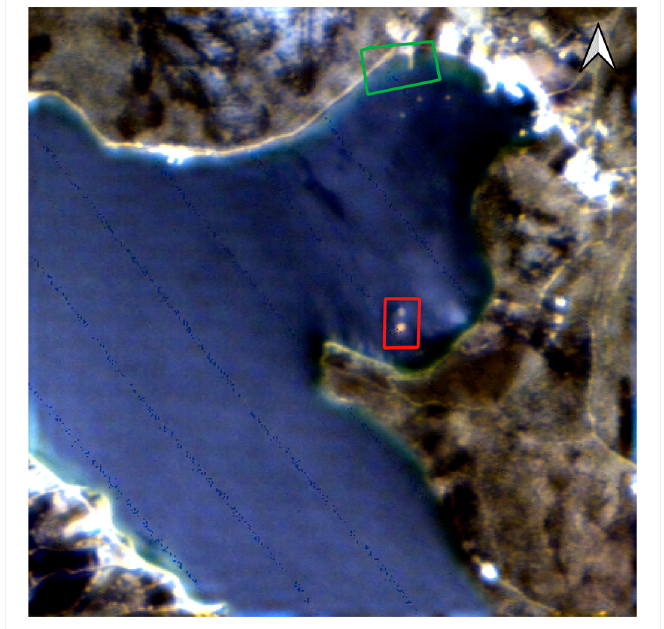
Figure 8. Red–Green–Blue image of the pan-sharpened PRISMA data collected over the Geras Gulf. The plastic targets were placed within the green rectangle. Two other large circular targets were placed in the Geras Gulf, one made of wood and the other of plastics (red) [23].